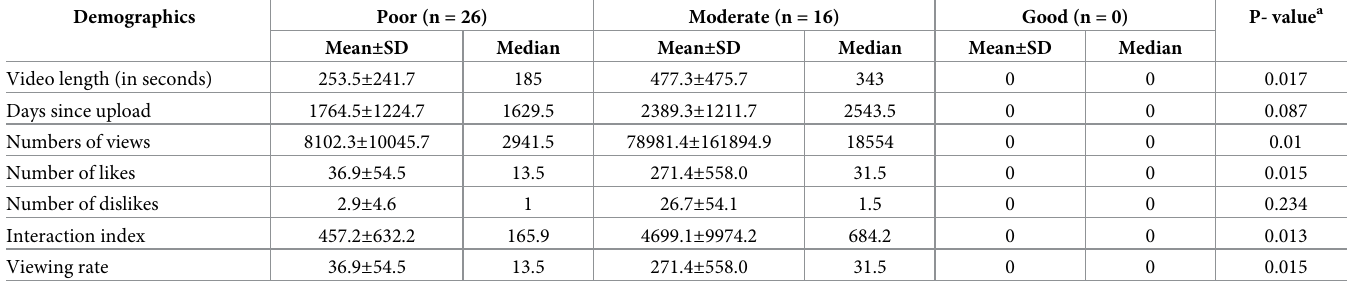
Table 4. Comparison of YouTube video demographics based on the usefulness score